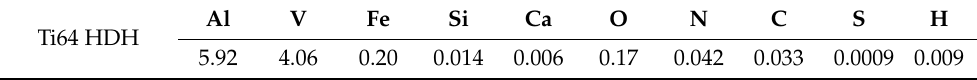
Table 3. Chemical composition of as-built